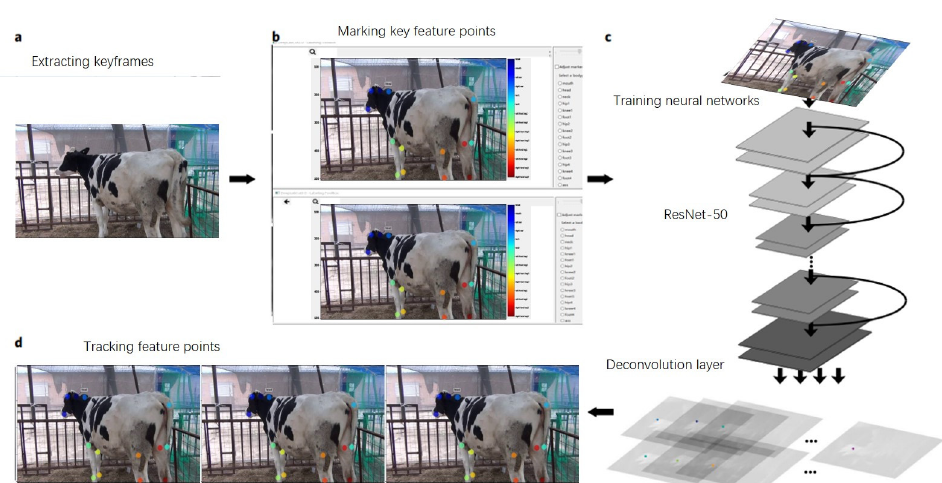
Figure 2. DeepLabCut flow and training architecture of the deep neural network (DNN). ( a ) Training: extract image key frames with different pose features of cow protective behavior. ( b ) Mark the body parts manually using different colors. Select the cow’s head, legs, and tail as the features of interest. ( c ) A deep neural network architecture is trained to predict the body part location based on the corresponding image to predict the probability of a body part being in a specific pixel. ( d ) The trained network can be used to extract the location of the body parts corresponding to the cow’s protective behavior from the video.